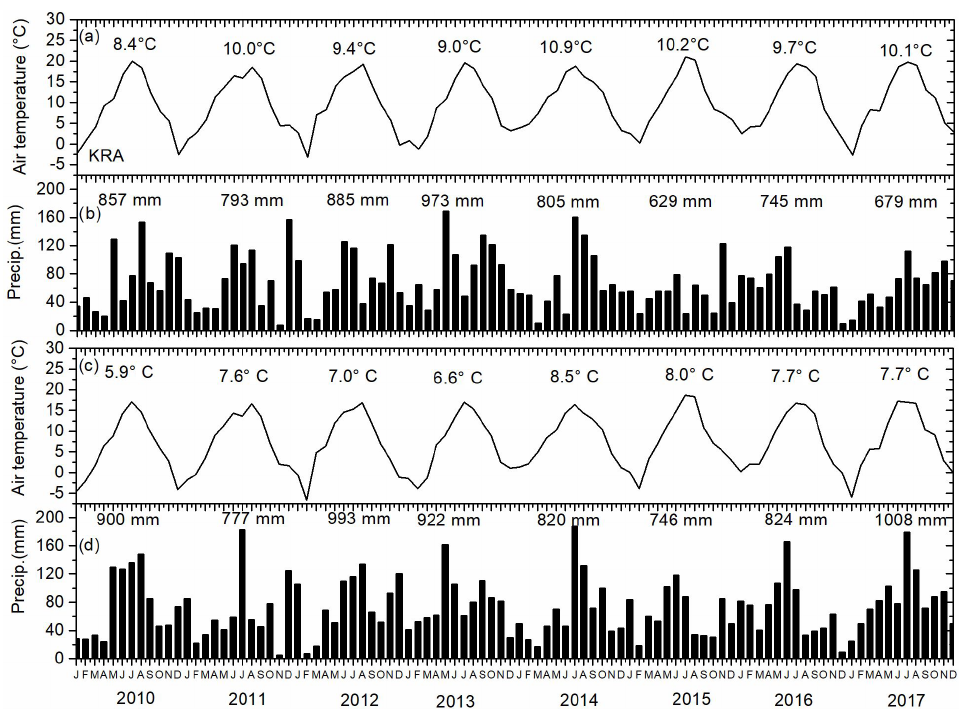
Figure 2. Mean monthly air temperatures and precipitation sums at the Kraichgau site EC1 and Swabian Jura site EC4 from 2010 to 2017. Annual mean temperatures and precipitation sums are given on top of the lines or